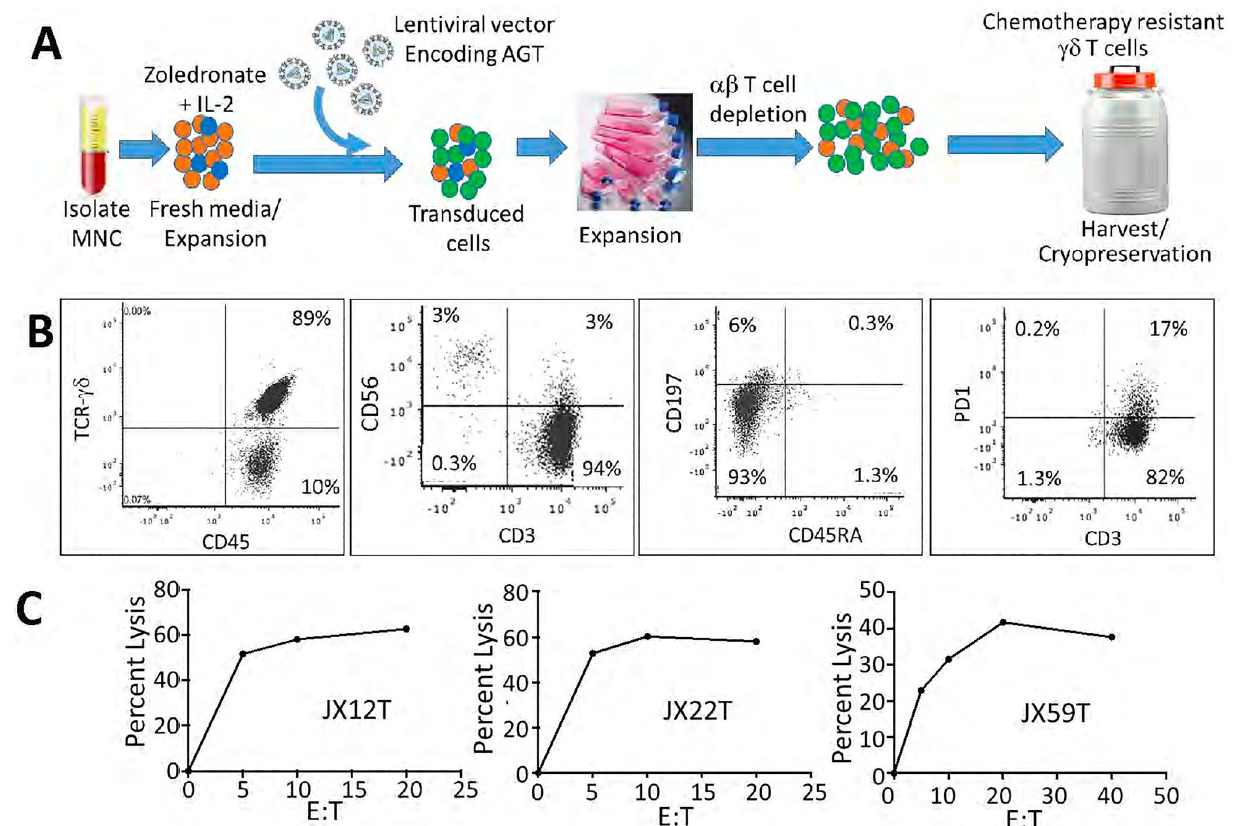
Figure 1. DRI product manufacturing protocol and phenotypic and functional characteristics of MGMT- modified and ex vivo expanded γδ T cells. ( A ) Following density gradient centrifugation, a 5 mL aliquot of apheresis product from a healthy volunteer is placed into culture media containing zoledronic acid and IL2 and incubated with P140K-MGMT lentiviral vector at an MOI of 10 on the fifth and sixth day of culture. The cell product is harvested when the γδ T-cell expansion plateaus, usually between days + 10 to + 16, αβ T cells are depleted if the γδ T cell content is < 70%, and the expanded cells are then cryopreserved for subsequent thawing and administration. ( B ) The final cell product contains 70–90% γδ T cells with a minimal component of αβ T cells and NK cells. Expanded γδ T cells exhibit effector/memory phenotype and minimal PD-1 expression and ( C ) show strong cytolytic activity against TMZ-resistant PDX cell lines JX12T and mesenchymal subtypes JX22T and JX59T following 4 h of co-incubation at 37